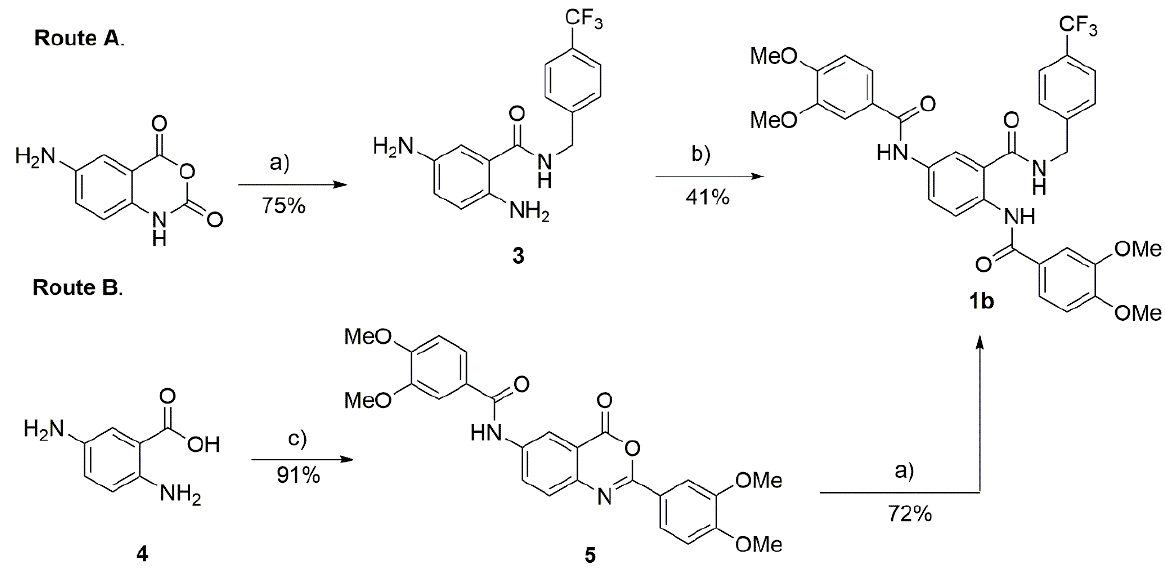
Scheme 1. Synthetic routes carried out for the preparation of compound 1b . (a) 4-trifluoromethylbenzylamine, DMF, room temperature; (b) 2 equivalents of 3,4-dimethoxybenzoyl chloride, pyridine, 0 ◦ C; (c) 3 equivalents of 3,4-dimethoxybenzoyl chloride, pyridine, 0 ◦ C.